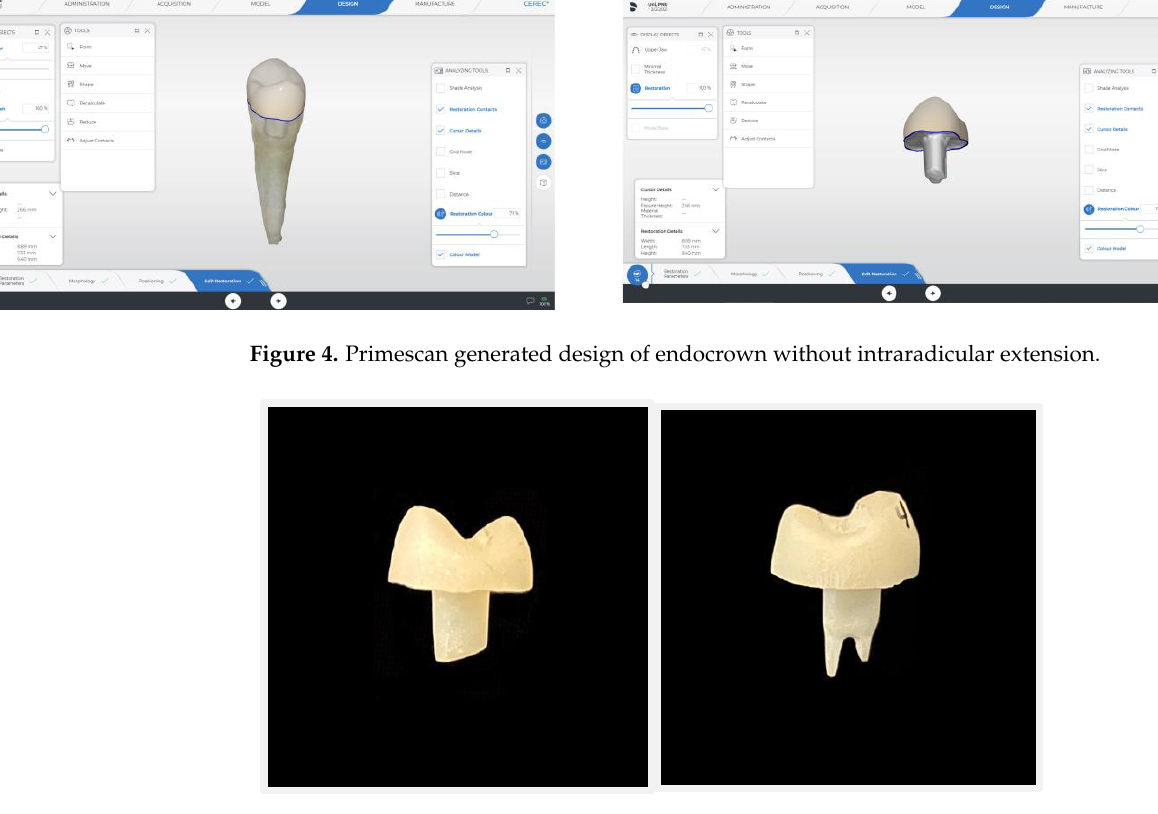
Figure 5. CAD/CAM-fabricated endocrown restoration.